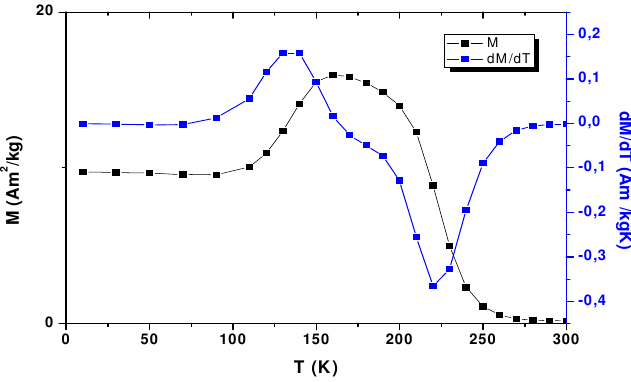
Fig. 2: Temperature dependence of magnetization and its derivate for La 0.5 Ca 0.5 MnO 3 sample at a magnetic applied field of 500